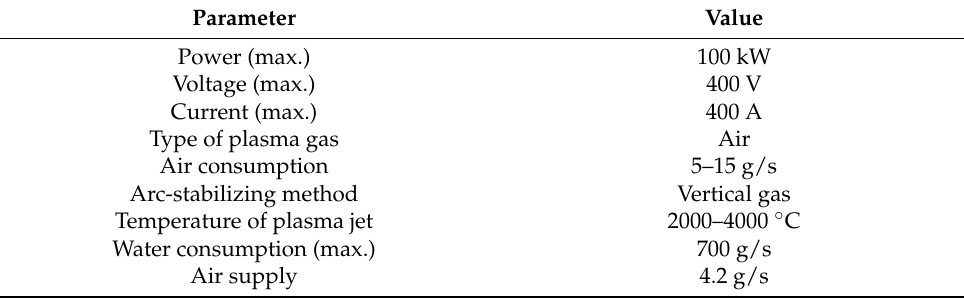
Figure 1. Plasma system used for phosphate waste treatment. Table 1. Parameters of arc plasma torch.